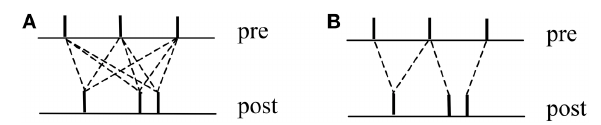
FIGURE 5 | (A) All-to-all spike interactions between pre- and post-synaptic neurons for STDP learning. Since the number of interactions is proportional to the square of firing rate, this paradigm is computationally expensive. (B) Presynaptic-centric spike interactions between pre- and post-synaptic neurons for STDP learning adopted in NeuroFlow. This method is computationally efficient and can approximate the all-to-all paradigm with high biological